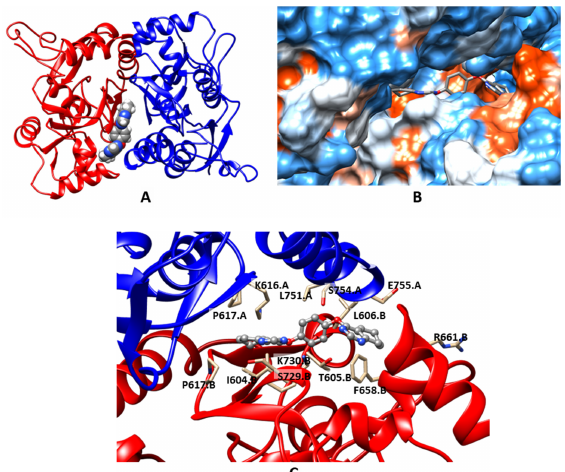
Figure 3. Binding mode of the PAM 1f , refined using molecular dynamics simulation (150 ns). ( A ) General view of the dimeric ligand binding domain of AMPA receptor (GluA2) and location of the binding site. ( B ) Binding pockets on the protein molecular surface colored by local hydrophobicity (brown for hydrophobic and blue for hydrophilic). ( C ) Detailed view of the binding site. The ligand is represented by a grey ball ‐ and ‐ stick model; the amino acid residues located within 3 Å of it are represented by beige stick ‐ models.